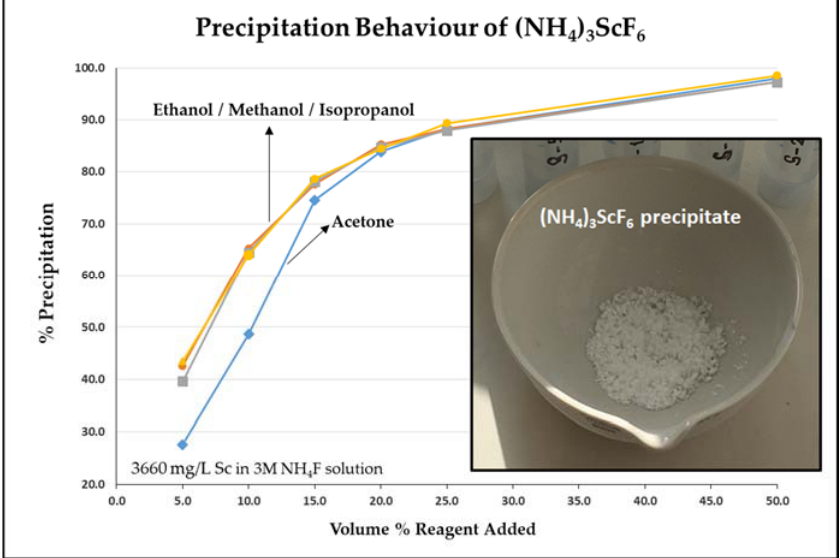
Figure 2. Effect of different anti-solvent addition on the crystallization behavior of scandium.